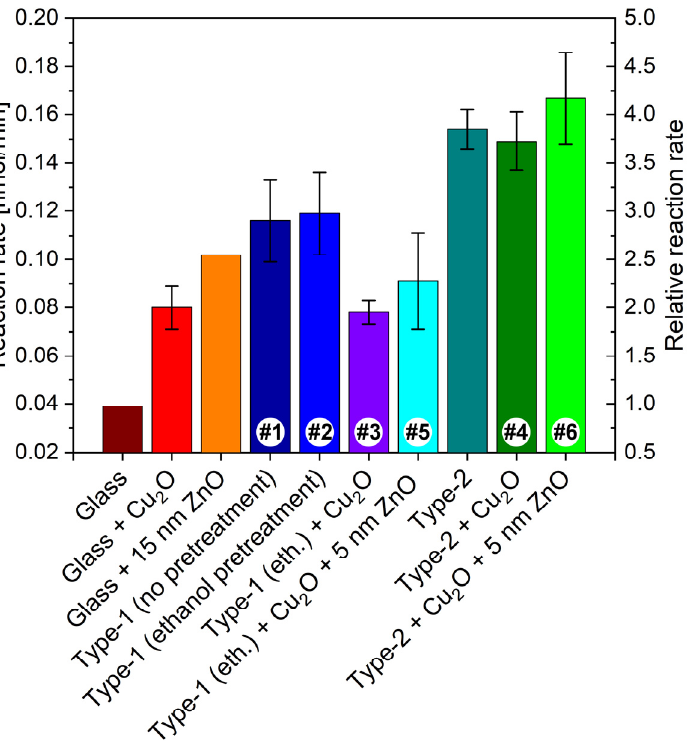
Figure 10. Absolute and relative reaction rates of the samples used to characterize the photocatalytic efficiency of the biotemplated photonic/photocatalytic nanoarchitectures. The value corresponding to bare glass was taken as unity for the calculation of the relative rates. The sample numbers on the bars are the same as those in Figure 9.